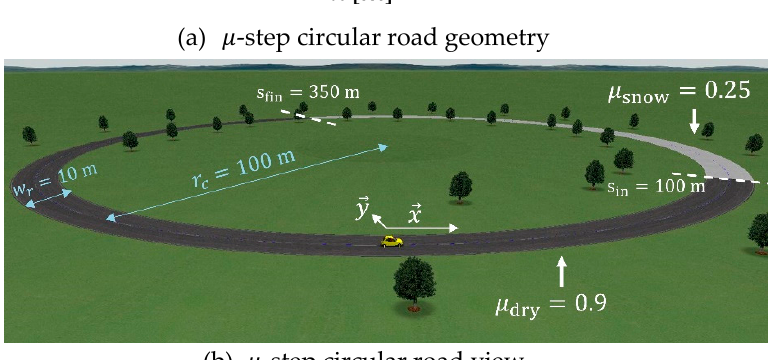
Figure 20. Bending on Low-Friction Patch: 100[m] radius circular with 𝜇 -varying. The vehicle is cruising at 56 [km/h] (Figure 21) on dry road, when it encounters the snow. In addition, the occurrence of a transient fault on the RL wheel is considered. In this test a sensor fault is simulated, due to − 7.5% error on the wheel speed measurement, the